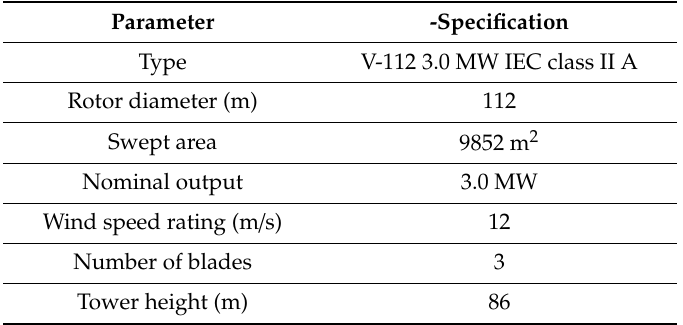
Table 4. V112-3MW turbine